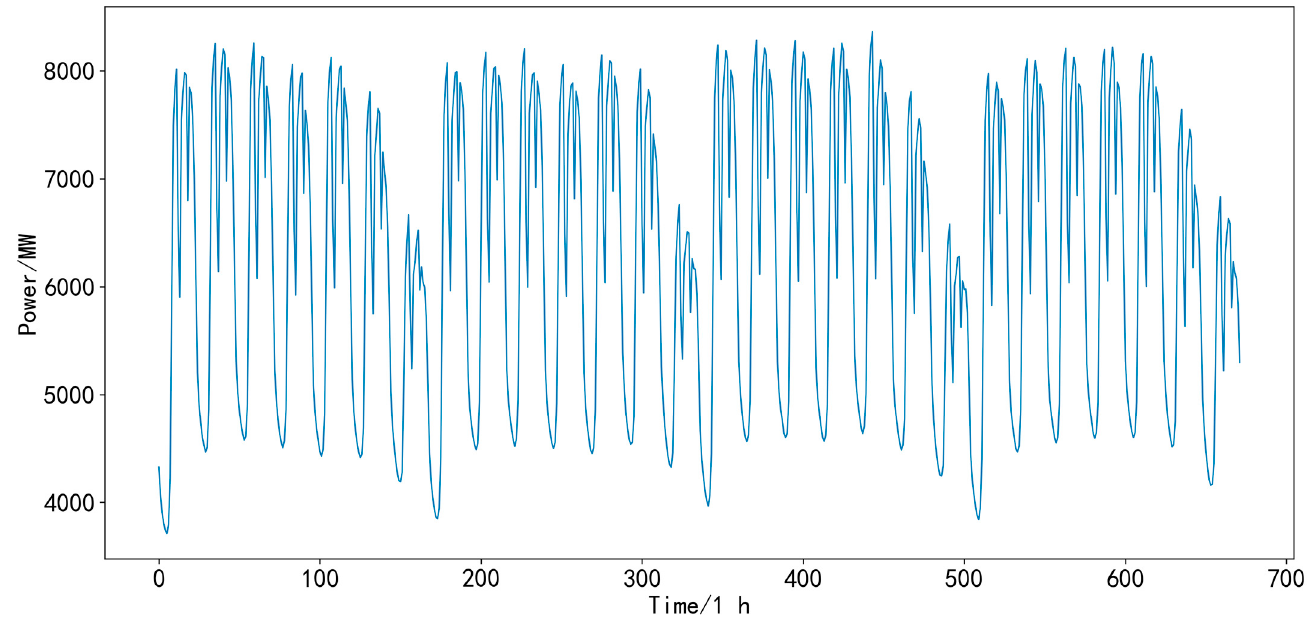
Figure 8. Annual load of Area 1.